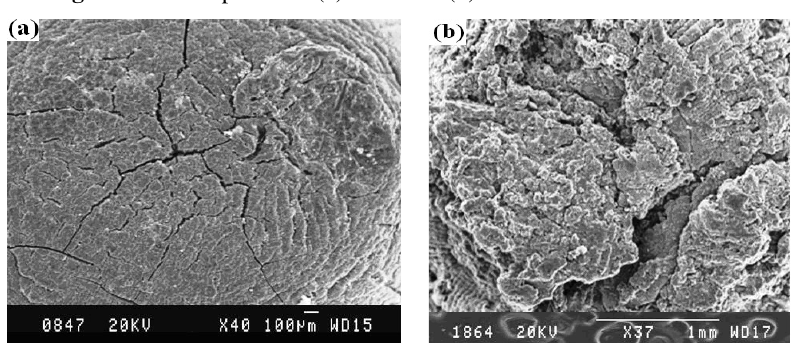
Figure 2. SEM images of (a) PCA and (b) PCA loaded with fluoride. Column adsorption